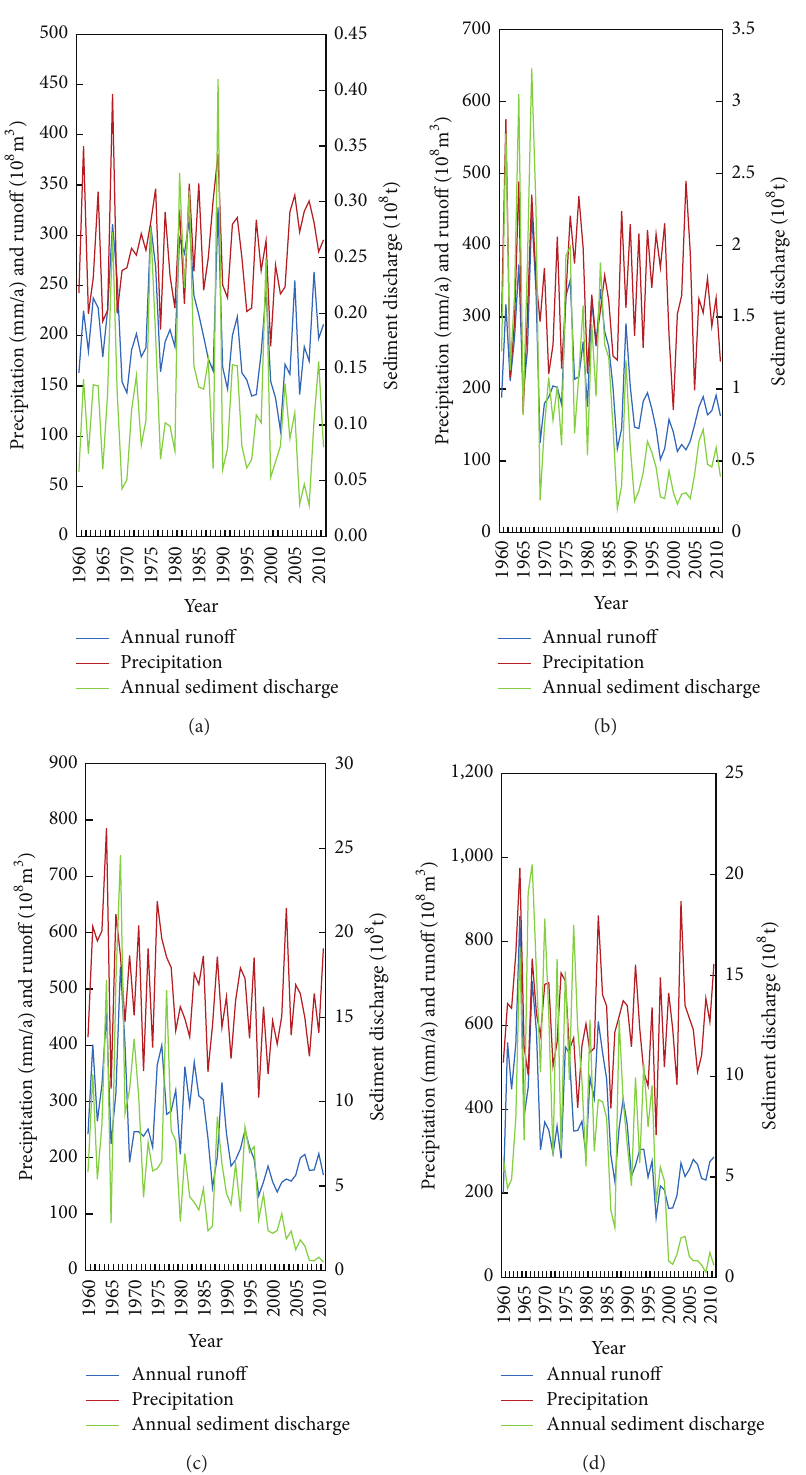
Figure 3: Changes of annual precipitation, runoff, and sediment discharge during the past 50 years (1960–2010) ((a) Tangnaihai, (b) Toud- aoguai, (c) Longmen, and (d)